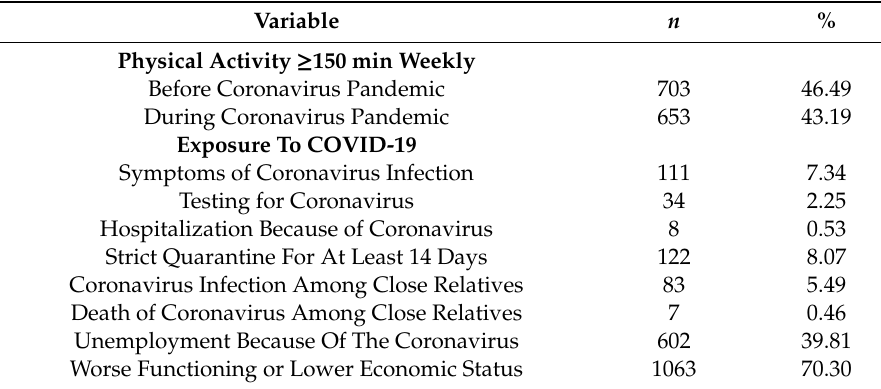
Table 2. Coronavirus-related